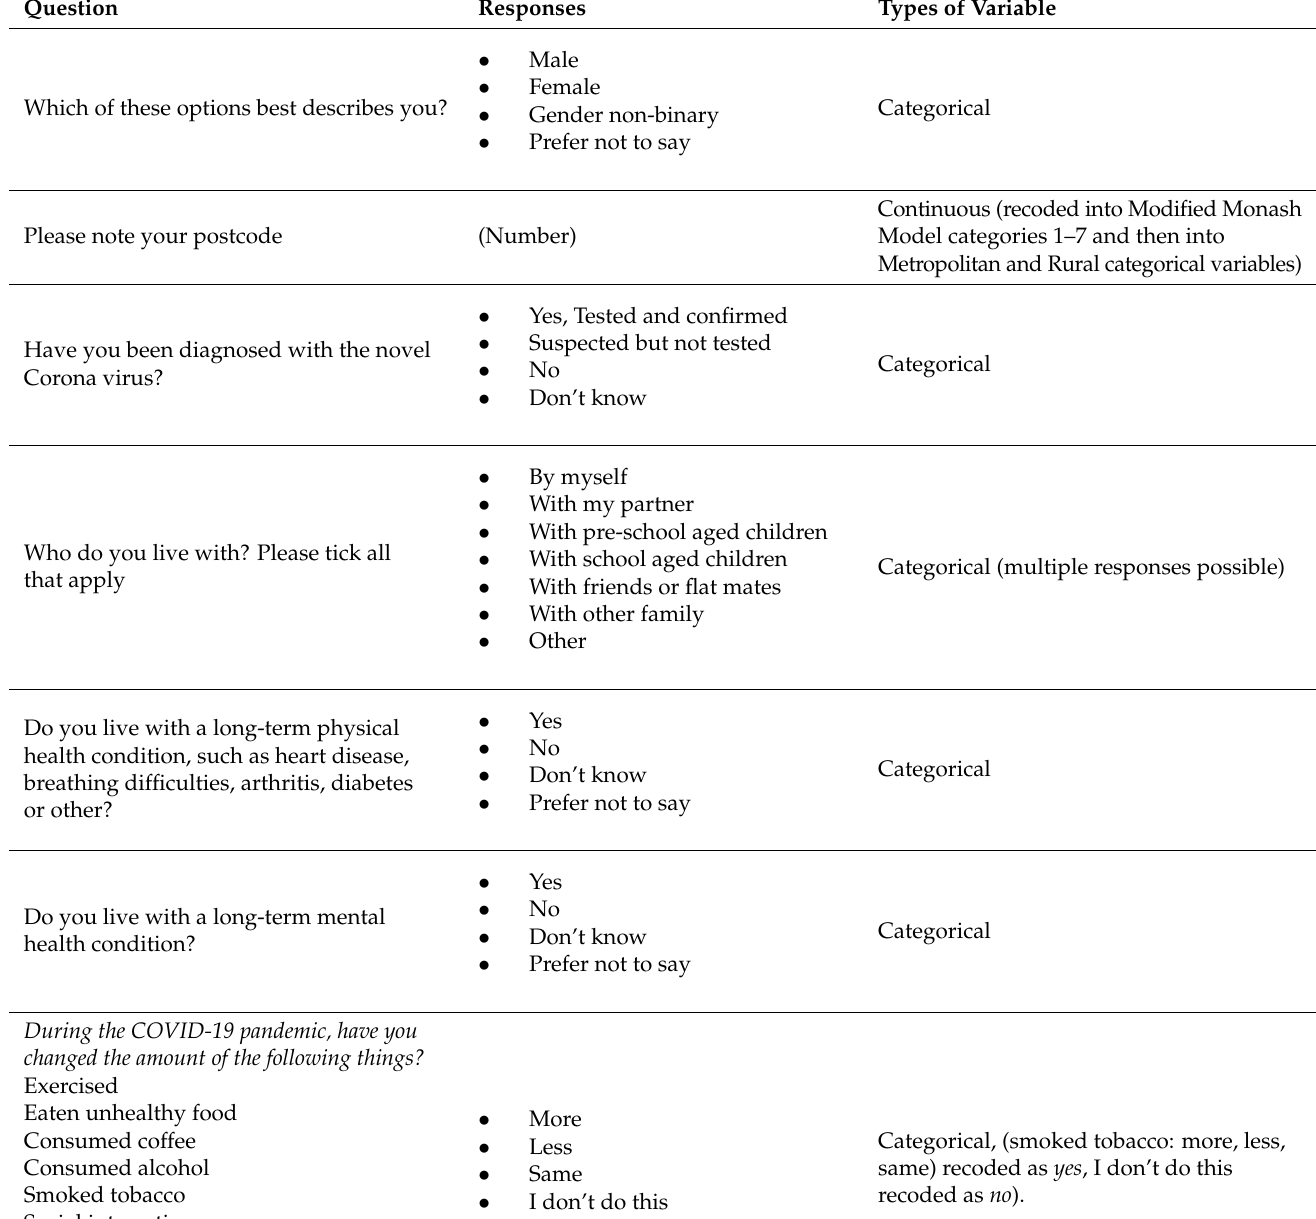
Table A1. Survey